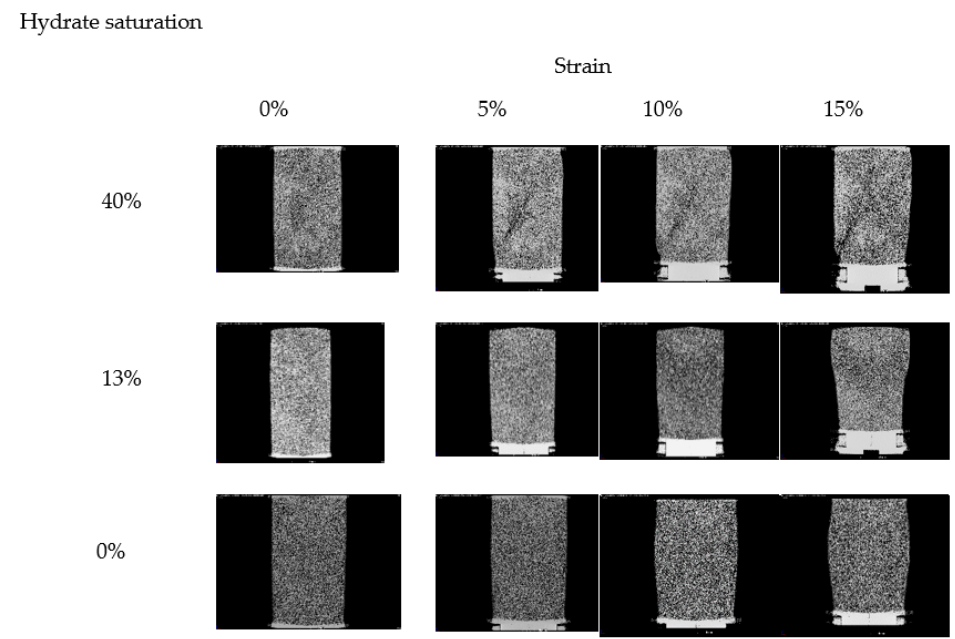
Figure 10. CT images with strain and hydrate saturation( σ 3 = 3MPa).